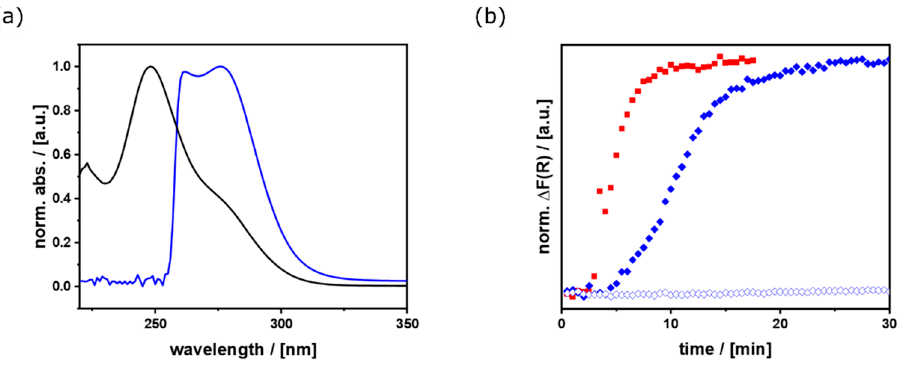
Figure 2. (a) UV/Vis absorbance spectra for the equimolar (MA:Pb) precursor systems with pure TEG (black) and 1:1 ( v : v ) mixture of TEG and DMF (blue); (b) UV/Vis kinetics for the three different precursor systems from time-dependent measurements while heating the precursors from 35 up to 75 °C (heat rate 16 °C/min), red (1.8 eq MABr in TEG-DMF; aborted after ~17 min, because no further changes were observed), solid blue (1 eq MABr in TEG-DMF), and clear blue (1 eq MABr in TEG).